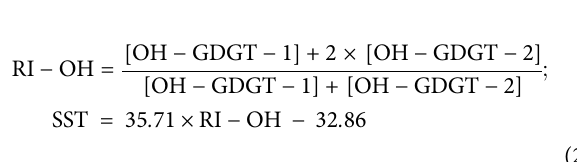
Frontiers in Earth Science |